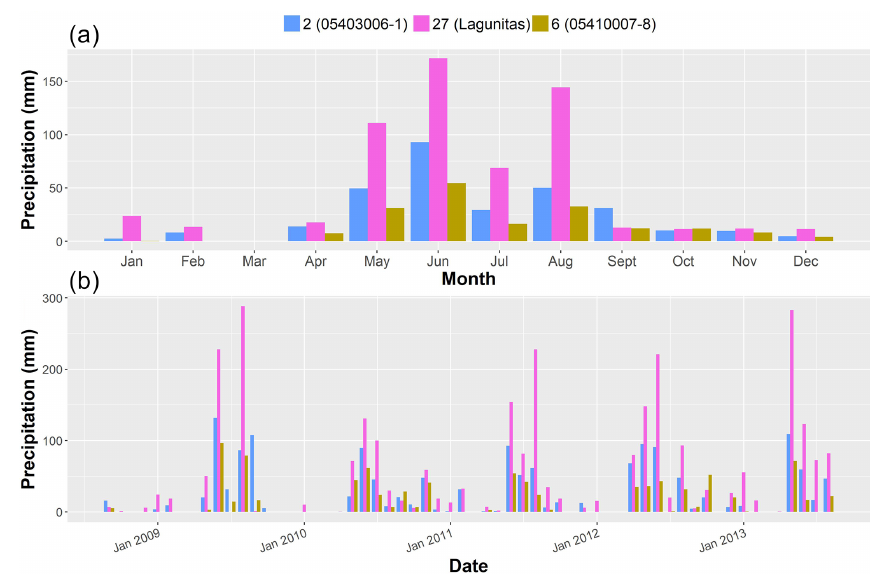
Figure 3. (a) Monthly average precipitation and (b) monthly precipitation over the period of analysis (September 2008–August 2013) for three of the gauges in the catchment. The numbers in the legend correspond to those in Fig. 1, while the text in parenthesis is the names of the gauges: Lagunitas (2765.5ma.s.l.), 05410007-8 (820ma.s.l.) and 05403006-1